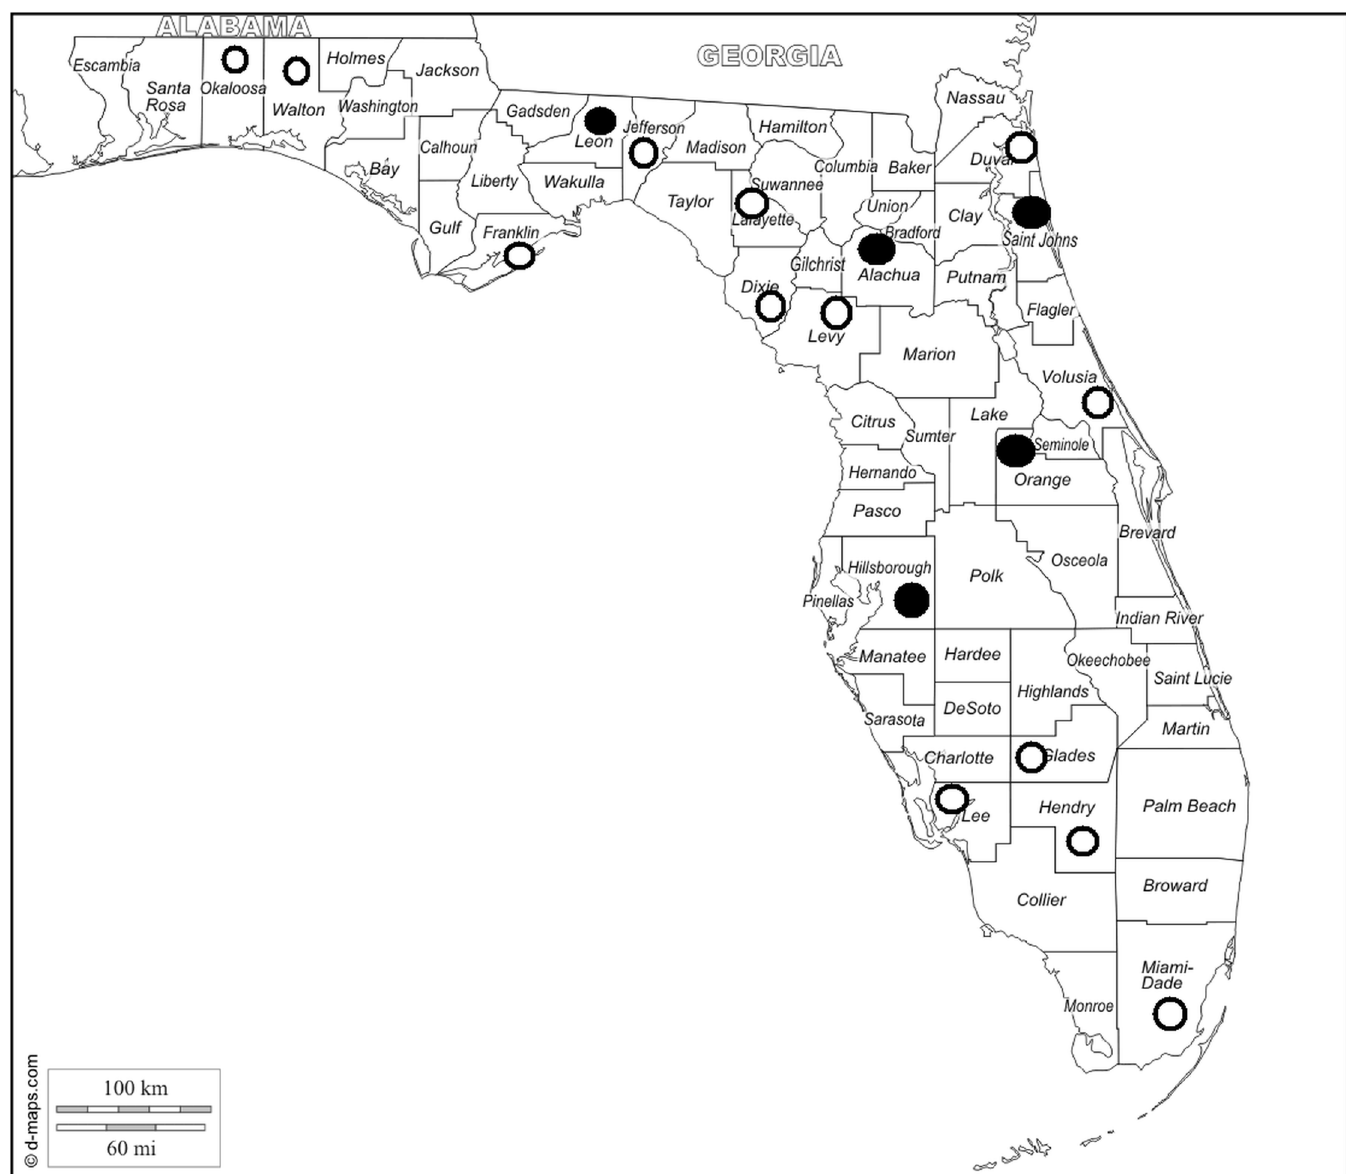
Fig 1. Surveyed counties in Florida, USA, indicating positive and negative areas for Angiostrongylus cantonensis . Countiesthat were positive for Angiostrongyluscantonensis from rat, environmental rat feces and/or gastropodssamples are marked with closed circles. Countiesnegativefor A . cantonensis are marked with open circles. The map can be found at http://www.d-maps.com/carte.php?num_car=6867&lang=en.